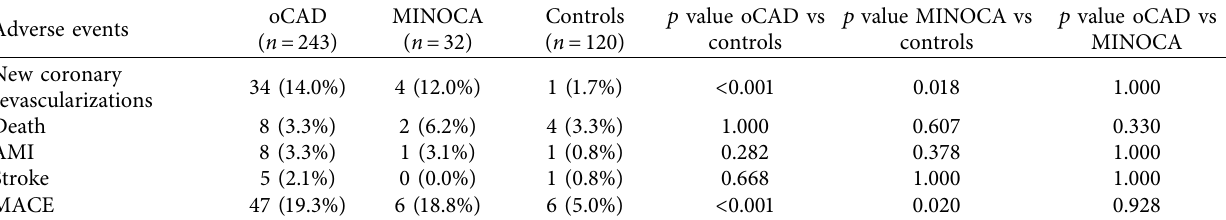
Table 4: Adverse events in the study period.